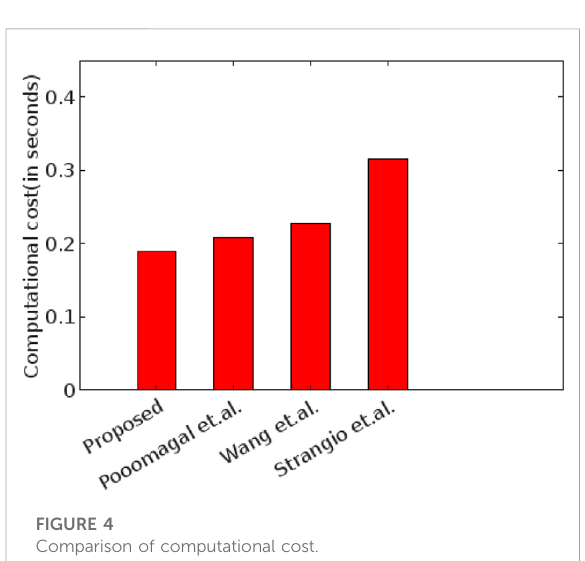
FIGURE 4 Comparison of computational